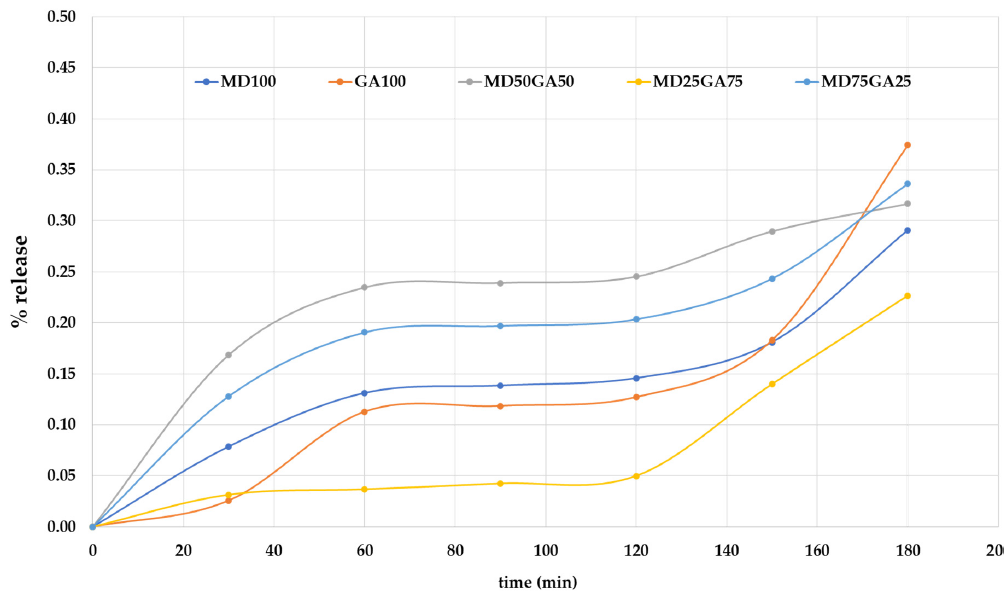
Figure 3. The percentage of volatile release as a function of